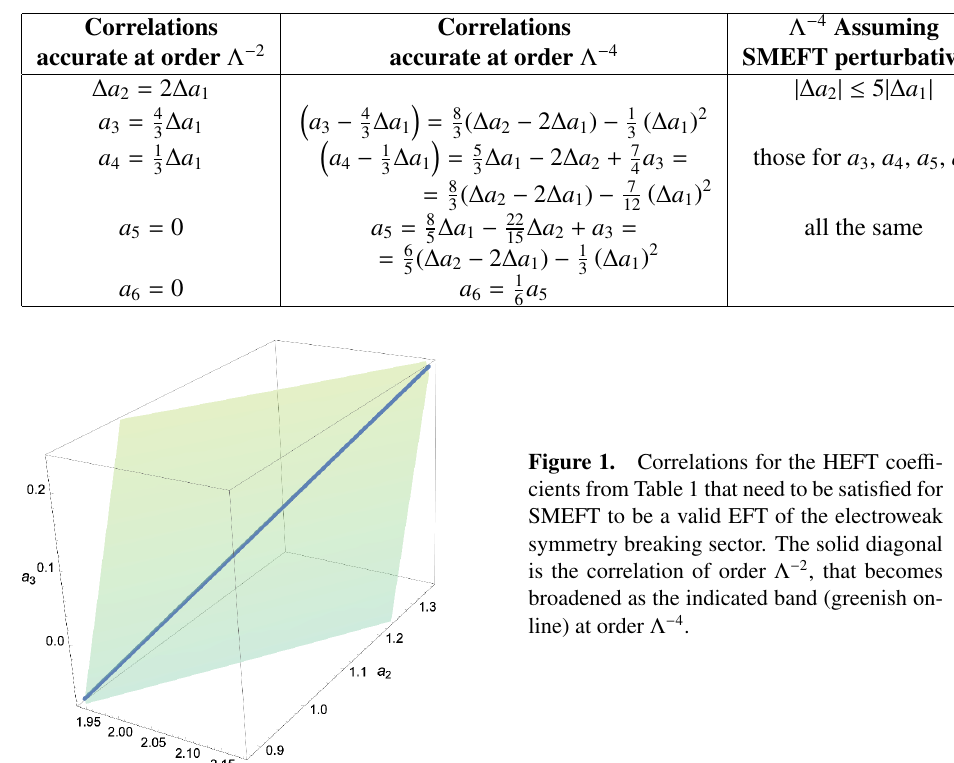
of Table 3, which can be tested in few-Higgs final states. A coupling c H (cid:2) (cid:2) 0 (stemming from the SMEFT operator relevant at the TeV scale for the electroweak symmetry breaking